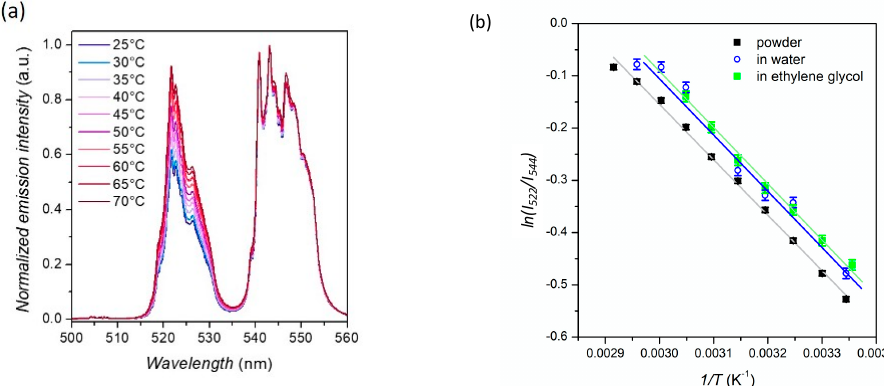
Figure 2. ( a ) Normalized PL spectrum of Yb 3+ ,Er 3+ -doped α -La(IO 3 ) 3 nanocrystals dried on a silicon wafer, normalized at 544 nm, as a function of temperature ( λ exc = 488 nm, 100 kW · cm − 2 ). ( b ) Evolution of the LIR = I 522 / I 544 ratio with temperature, for Yb 3+ ,Er 3+ -doped α -La(IO 3 ) 3 nanocrystals in different